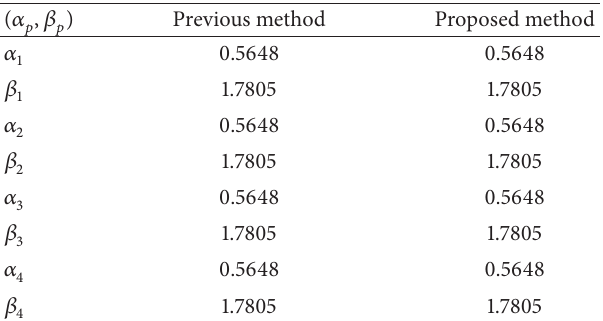
Table 6: The time cost by two methods in a special circumstance